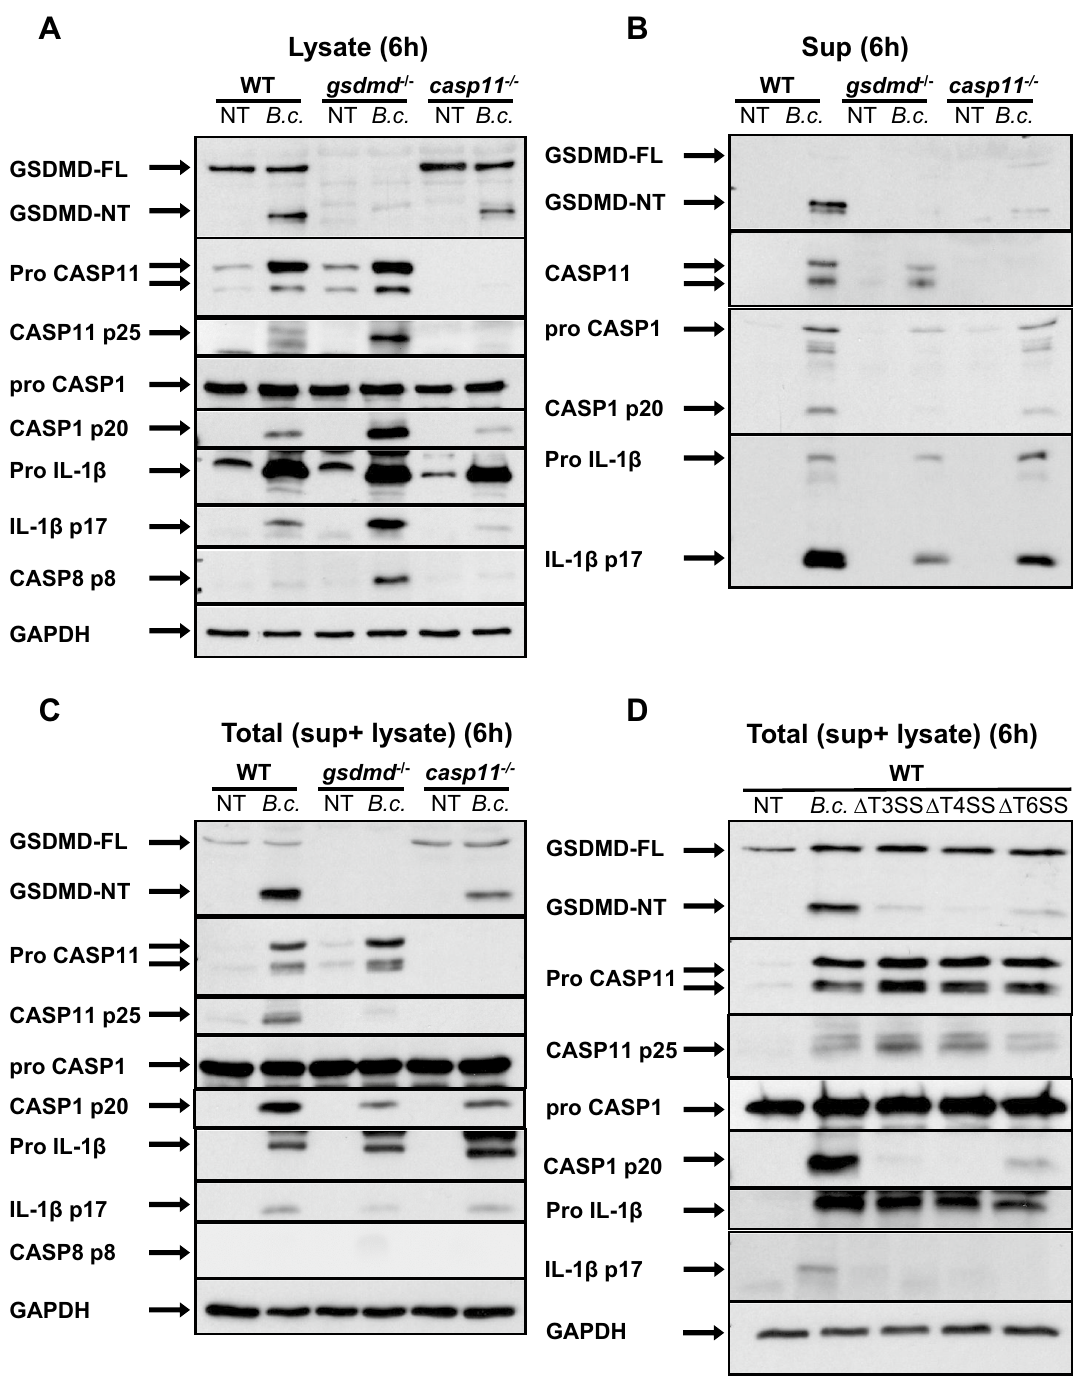
Figure 1. CASP11, CASP1, and bacterial secretory systems influence GSDMD cleavage in B. cenocepacia - infected macrophages. (A) Immunoblot analysis of GSDMD, CASP11, CASP1, IL-1β, CASP8, and GAPDH in whole cell lysate of WT, gsdmd −/− , and casp11 −/− macrophages infected with B. cenocepacia ( B.c. ) (MOI10) at 6 h post-infection. (B) Immunoblot analysis of GSDMD, CASP11, CASP1, and IL-1β in cell supernatant (sup) from WT, gsdmd −/− and casp11 −/− macrophages treated as in ( A ). (C) Immunoblot analysis of GSDMD, CASP11, CASP1, IL-1β, CASP8, and GAPDH in total cell lysate and sup from WT, gsdmd −/− , and casp11 −/− macrophages treated as in ( A ). (D) Immunoblot analysis of GSDMD, CASP1, CASP11, IL-1β, and GAPDH in total cell lysate and sup from WT macrophages infected with WT B. cenocepacia , ∆T3SS, ∆T4SS, and ∆T6SS mutants (MOI10) at 6 h post-infection. ( A – D ) Representative blots from 3 independent